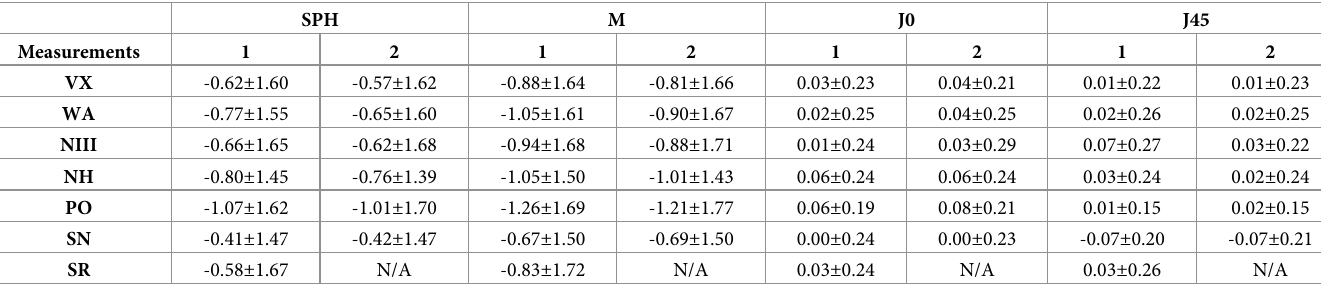
Table 2. Refractive outcomes obtained with each autorefractor. SPH M